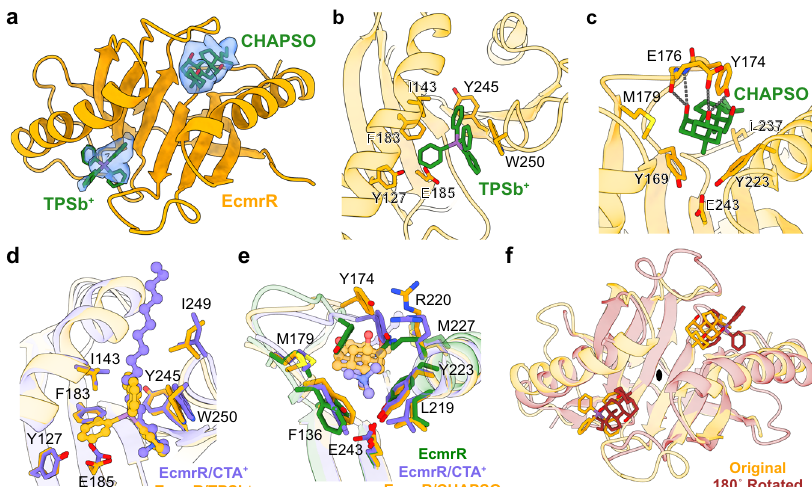
Fig. 4 Two ligand-binding sites in EcmrR. a Overview of two ligand-bindings sites in EcmrR. Only the CTD of one EcmrR subunit is shown. Two bound ligands, TPSb + and CHAPSO, are displayed as green sticks and are superimposed with the cryo-EM density (blue surfaces) contoured at 7 σ . b Interactions between TPSb + and EcmrR in ligand-binding site I. Ligand-interacting residues in EcmrR are shown as orange sticks. c Interactions between CHAPSO and EcmrR in ligand-binding site II. Ligand-interacting residues in EcmrR are shown as orange sticks. Hydrogen bonds are shown as gray dotted lines. d Comparison of EcmrR ligand-binding site I between the CTA + -bound and TPSb + -bound forms. Crystal structure of EcmrR CTD/CTA + complex is superimposed with the structure of EcmrR/TPSb + /CHAPSO subcomplex in EcmrR-RP itc-4nt . Ligands are shown in ball-and-stick representation and EcmrR residues contacted by ligands are shown in stick representation. e Comparison of EcmrR ligand-binding site II among the unbound, CTA + -bound and CHAPSO-bound forms. Crystal structure of EcmrR CTD/CTA + complex and EcmrR/TPSb + subcomplex in EcmrR-RP itc-3nt are superimposed with the structure of EcmrR/TPSb + /CHAPSO subcomplex in EcmrR-RP itc-4nt . f Pseudo two-fold symmetry of EcmrR CTD. The structure of EcmrR CTD with TPSb + and CHAPSO bound to its two ligand-binding sites is rotated 180° along a hypothetical axis (indicated by a black ellipse) and overlapped with the original